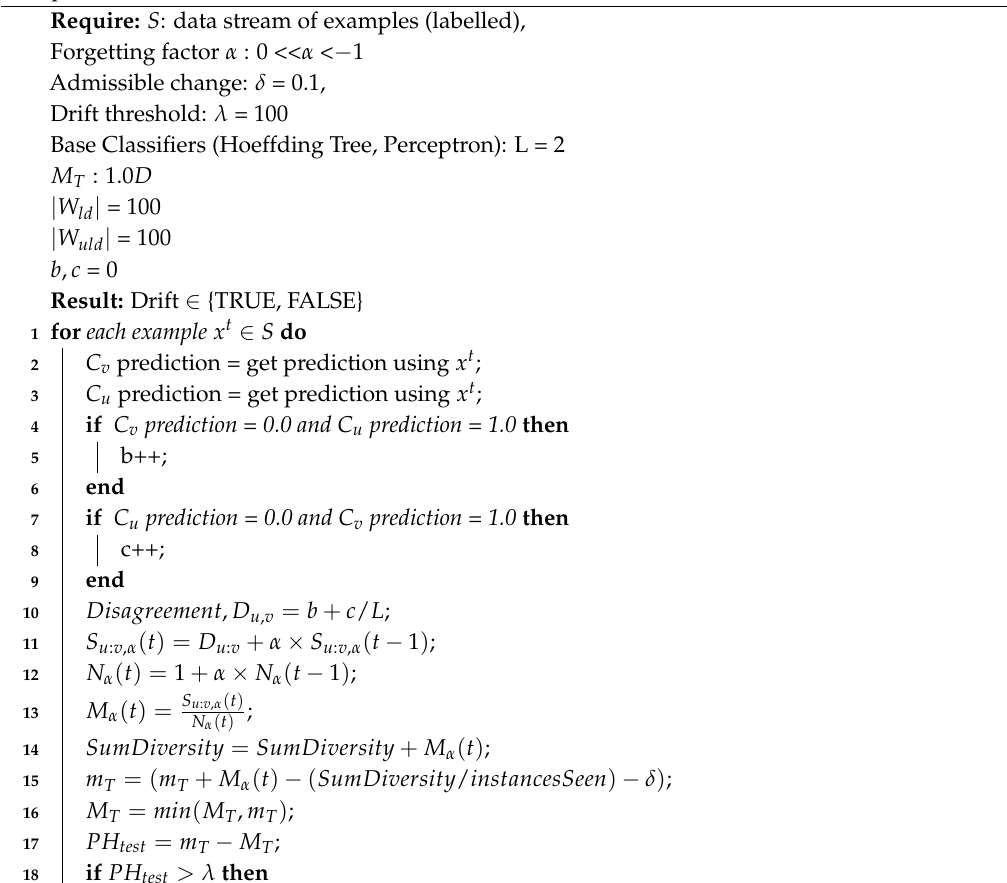
Algorithm 1: Pseudocode of Diversity Measure as a Drift Detection Method in a Semi- Supervised Environment